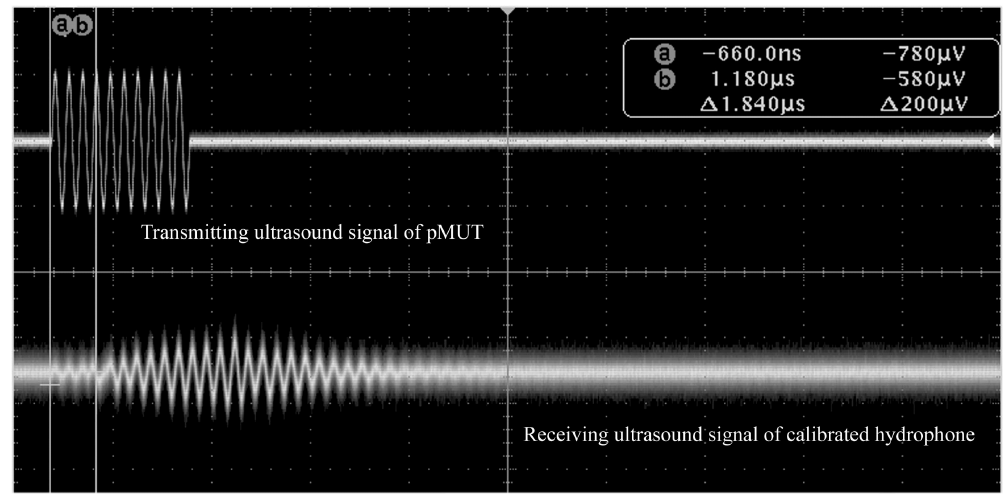
Figure 15. Measurement results of transmitting sensitivity of a pMUT with partially-etched ZnO film.